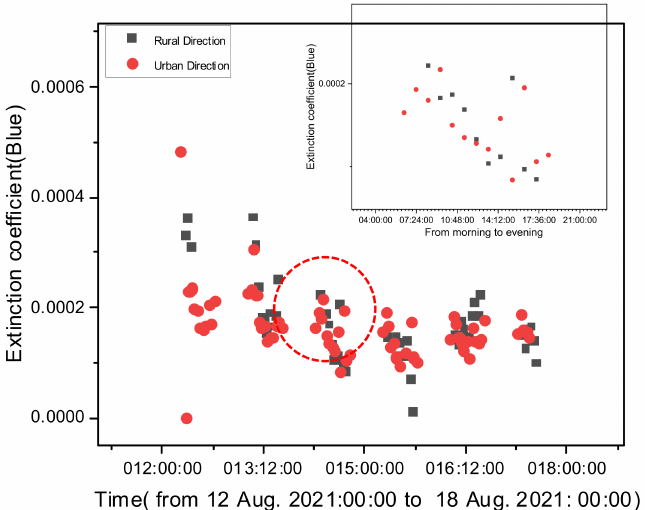
Figure 7. Daily change in the extinction coefficients measured in the downtown direction and the National Park direction in Daejeon, Korea for one week from 12 to 17 August